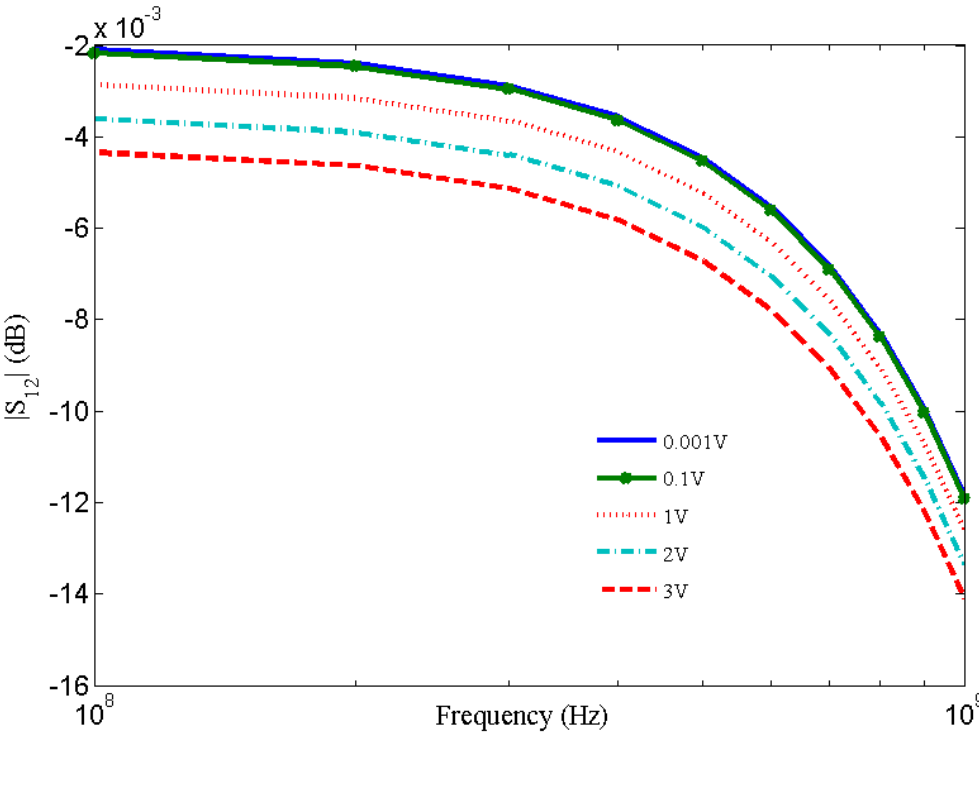
parameter of SWCNT interconnects at different bias Figure 8. S 12